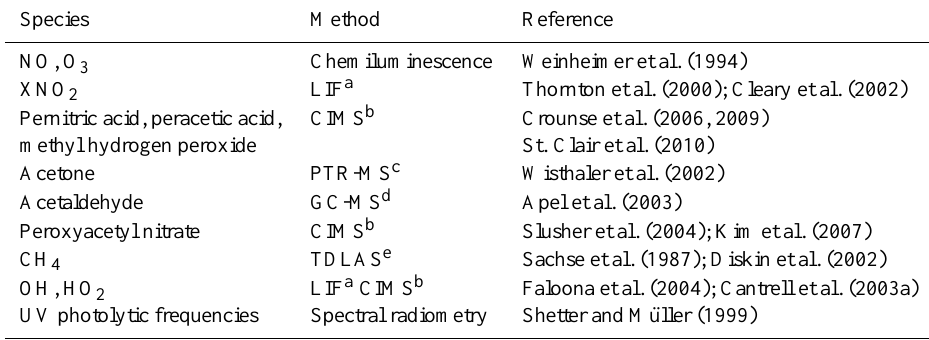
Table 1. Measurements used in this analysis to constrain the photostationary state model. XNO 2 refers to the sum of NO 2 and the fraction of CH 3 O 2 NO 2 +HO 2 NO 2 that thermally dissociate in the inlet of the LIF instrument. Species Method Reference NO, O 3 Chemiluminescence Weinheimer et al. (1994) XNO 2 LIF a Thornton et al. (2000); Cleary et al. (2002) Pernitric acid, peracetic acid, CIMS b Crounse et al. (2006, 2009) methyl hydrogen peroxide St. Clair et al. (2010) Acetone PTR-MS c Wisthaler et al. (2002) Acetaldehyde GC-MS d Apel et al. (2003) Peroxyacetyl nitrate CIMS b Slusher et al. (2004); Kim et al. (2007) CH 4 TDLAS e Sachse et al. (1987); Diskin et al. (2002) OH, HO 2 LIF a CIMS b Faloona et al. (2004); Cantrell et al. (2003a) UV photolytic frequencies Spectral radiometry Shetter and M¨uller